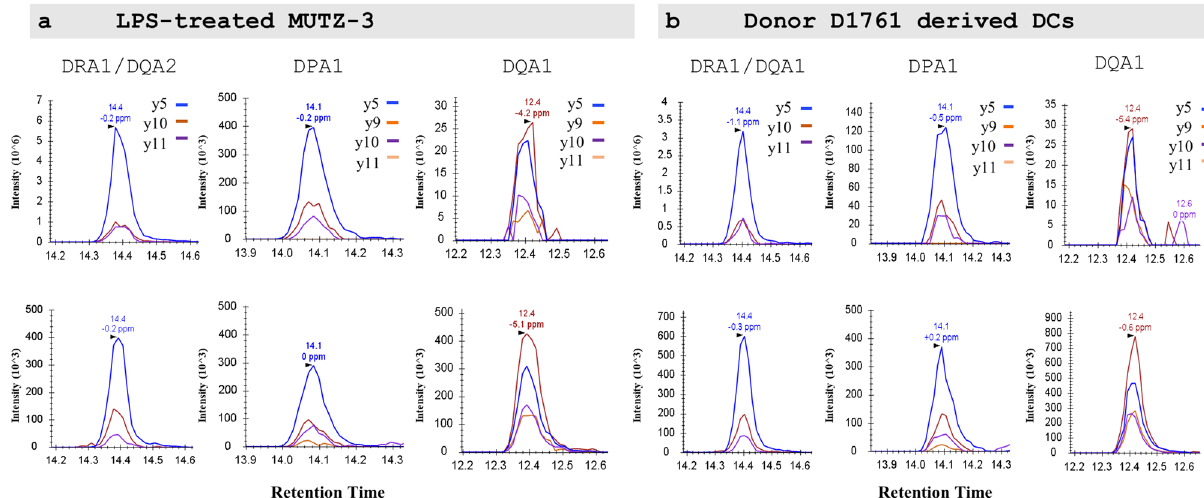
Figure 4. Ion chromatograms detecting endogenous (top panel) and spiked stable isotope labelled peptides (bottom panel). VEHGLD E PLLK (DRA/DQA2); VEHGLD Q PLLK (DPA1); VEHGLD K PLLK (DQA1) by parallel reaction monitoring (PRM) in trypsin digested lysates from ( a ) LPS-treated MUTZ-3 and ( b ) donor D1761-derived DCs. Representative signals of fragment ion transitions for each HLA α-chain detected in HLAII-immunoprecipitants equivalent to 100,000 cells for ( a ) and ( b ) are